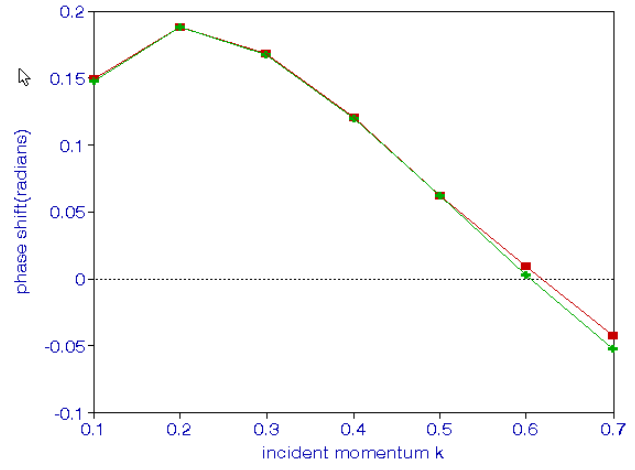
Figure 3. (Color online). The upper curve represents phase shifts for positron–hydrogen scattering using hybrid theory and the lower curve represents those obtained using the Feshbach formalism.